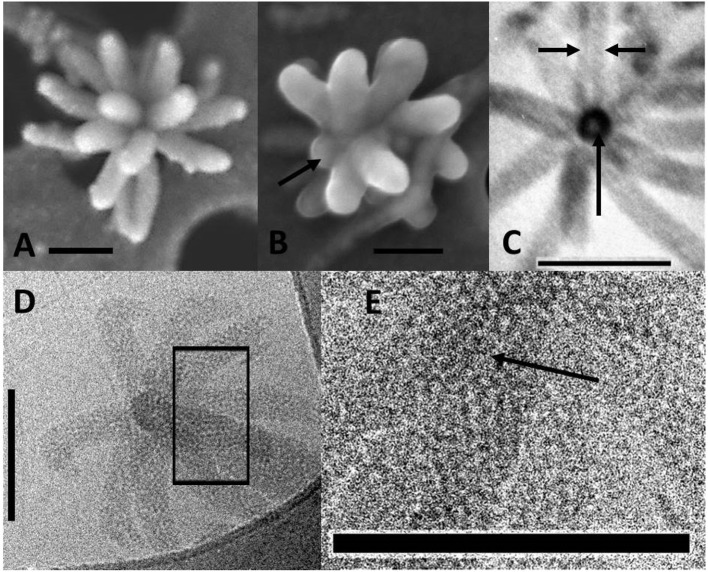
Electromicrographs of aster-like nanoparticles (ALNs). (A,B) Scanning electron microscopy (SEM) micrographs showing ALNs with multiple full-grown radial arms (A) or a mix of emerging (arrow) and full-grown arms (B). (C) TEM micrograph of an ultra-thin section of an ALN. Sagittal sections of arms reveal a tubular appearance with electron light area enclosed by a wall-like structure (arrows). (D,E) Cryo-TEM micrographs. (D) Radial arms display a similar mottled appearance. (E) Magnified view of the box selected from the previous image revealing circular substructures (arrow). Scale bars = 100 nm.